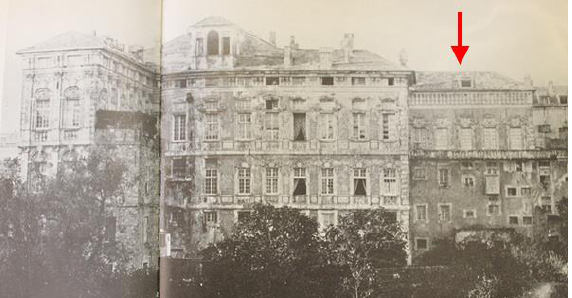
Figure 3. collection Guido Orazio Borea d’Olmo, iconographic text “Sanremo com’era”, Editrice Collins, Milano